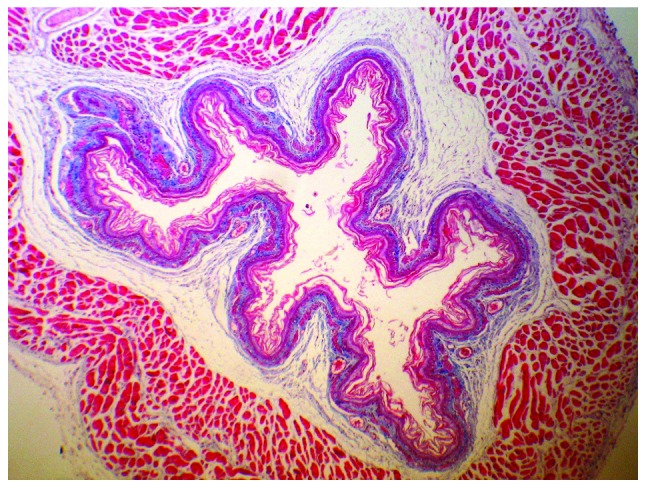
A mild increase in collagen deposition was observed in the muscularis mucosa, submucosa and tunica muscularis in the steroid treatment group (magnification, ×100; staining, hematoxylin-eosin and Masson’s trichrome).